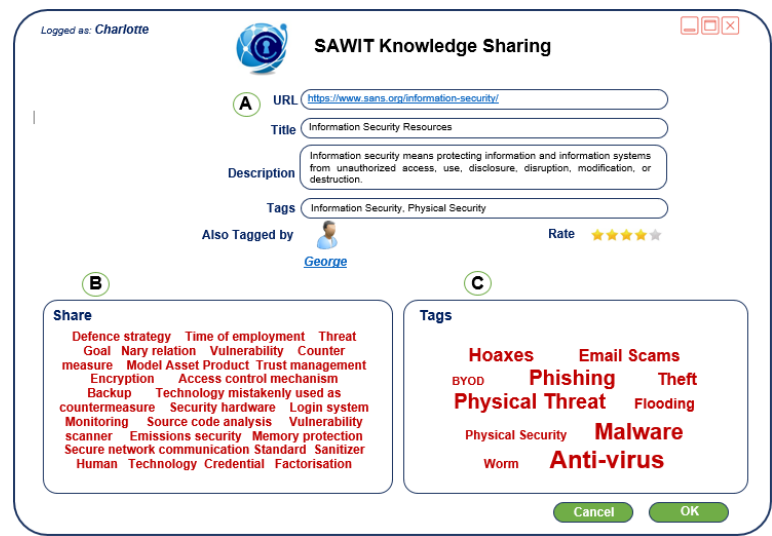
Figure 2. SAWIT knowledge sharing dialog. ( A ) Dublin Core Terms ( B ) Security Domain Concepts ( C ) User-defined Tags.